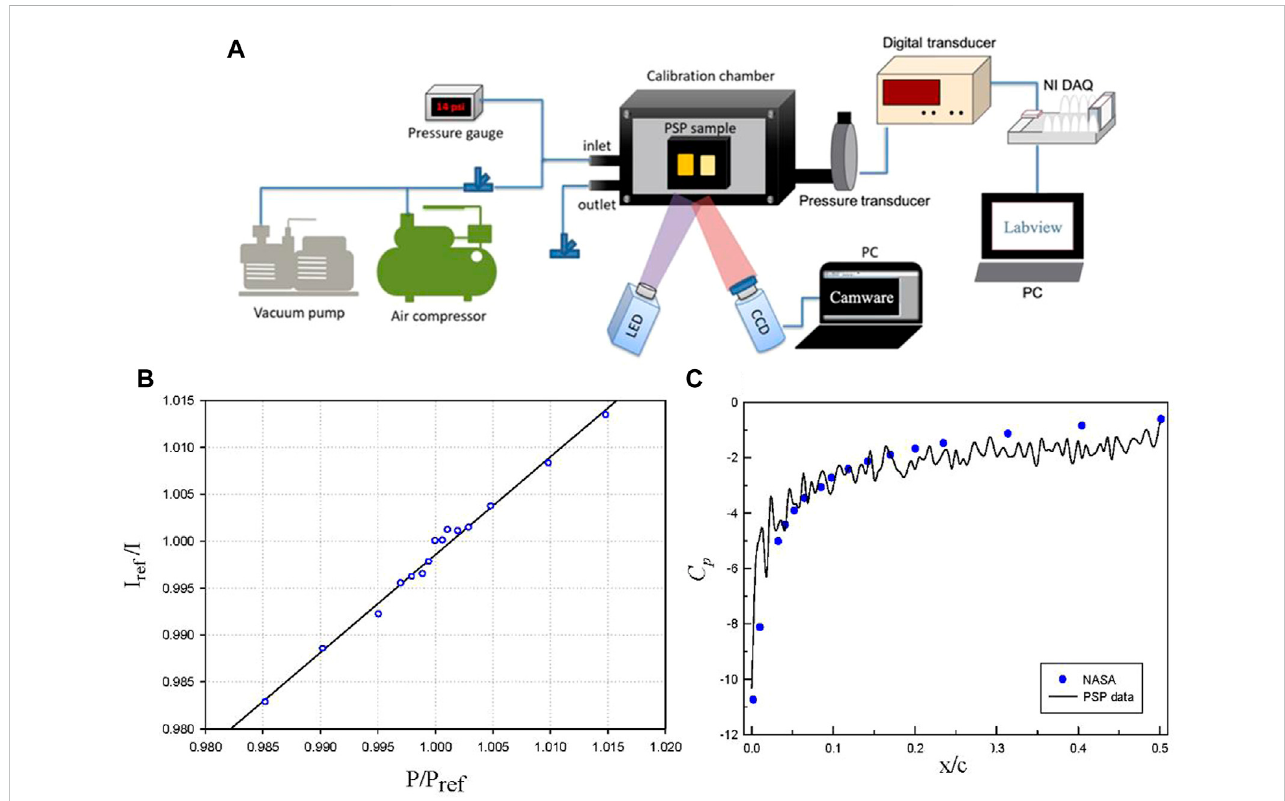
FIGURE 3 (A) Schematicdiagram ofthePSP calibrationsetup. (B) The Calibration curvefor UniFIB PSP at atemperatureof26 ° C. (C) The validation of UniFIB PSP by measuring the pressure coef fi cient for a NACA0012 airfoil at the freestream velocity of 40.0 m/s and an angle of attack of 15 ° .